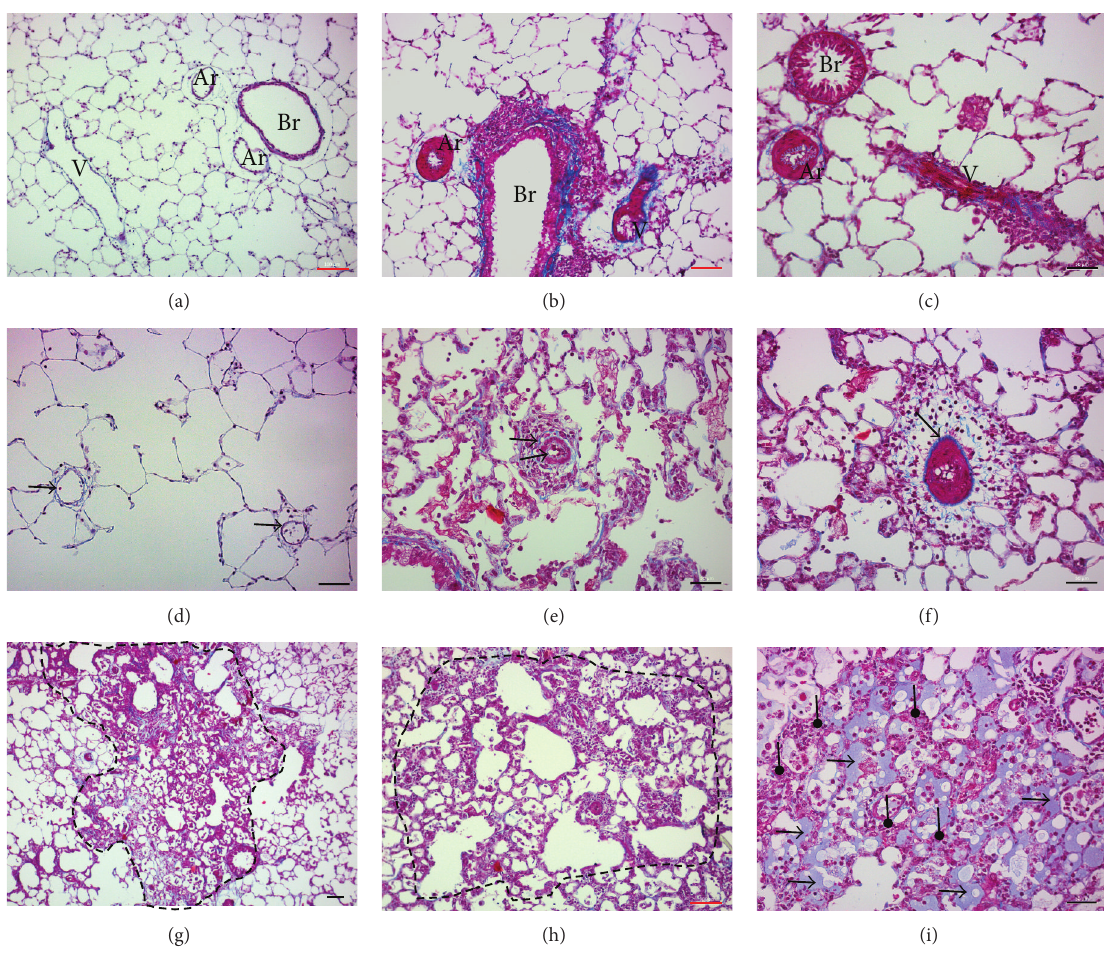
Figure 1: MMC induces pulmonary vascular remodeling in the rat, with pulmonary venous and capillary lesions mimicking capillary hemangiomatosis found in PVOD patients. ((a) and (d)) Control lung. ((b)-(c), (e)–(i)) MMC-exposed lung. (a) Control pulmonary artery (Ar)andvein(V)closetothebronchus(Br).((b)-(c))Remodelingofpulmonaryarteriesandveinsclosetothebronchiattwolevelsofdistality. (d) Control distal microvessels (arterioles and venules are indistinguishable) (arrows). (e) Remodeled distal pulmonary arteriole delimited by apparent internal and external elastica (blue stained) (arrow). (f) Remodeled distal pulmonary venule delimited by single elastica (blue stained) (arrow). ((g)-(h)) Foci of alveolar-wall thickening suggestive of pulmonary capillary hemangiomatosis (dotted line area). (i) Foci of pulmonary edema (arrow) and capillaritis (arrowhead). ((a)–(i)) Masson’s trichrome stained paraffin-embedded tissue sections: muscle fibers (red), collagen (blue), light red/pink (cytoplasm), and cell nuclei (dark brown/black). Red scale bar = 100 𝜇 m. Black scale bar = 50 𝜇